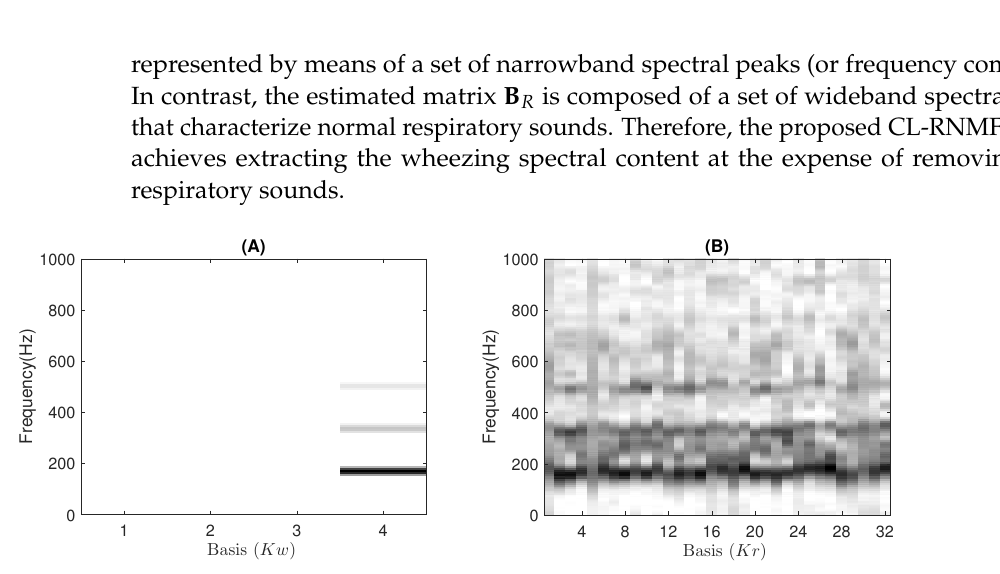
Figure 4. Example of the estimated matrices B W and B R obtained from the proposed CL-RNMF approach, analyzing the MP wheezing spectrogram previously shown in Figure 1B. ( A ) Although the matrix B W is composed of four spectral bases, the spectral wheezing patterns are compacted into the fourth basis B W ( 4 ) . This spectral basis B W ( 4 ) is composed of three narrowband spectral peaks. ( B ) The matrix B R is composed of thirty-two wideband spectral bases.